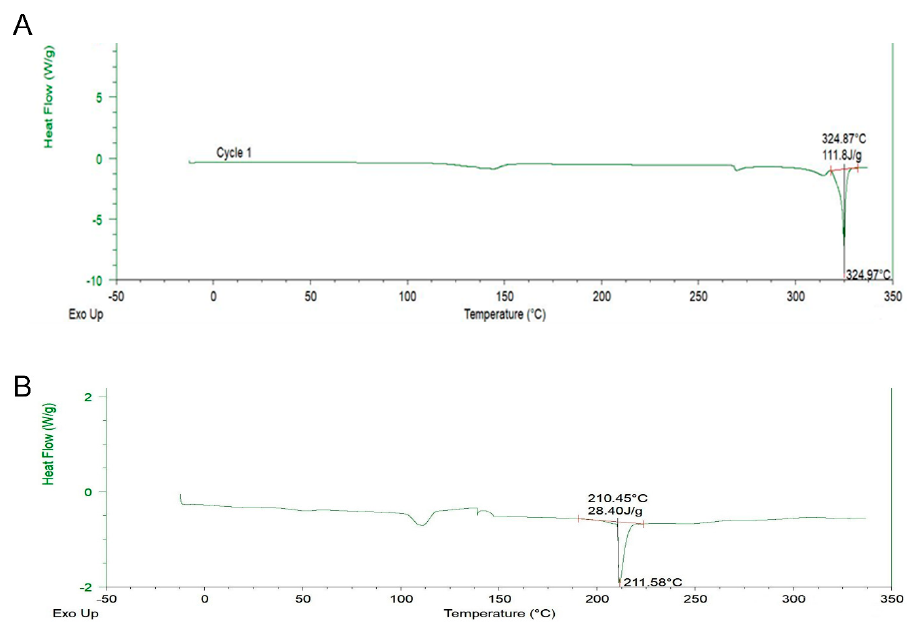
Figure 4. Differential scanning calorimeter (DSC) thermograms of ( A ) Qu and ( B ) Qu-PEG NS.